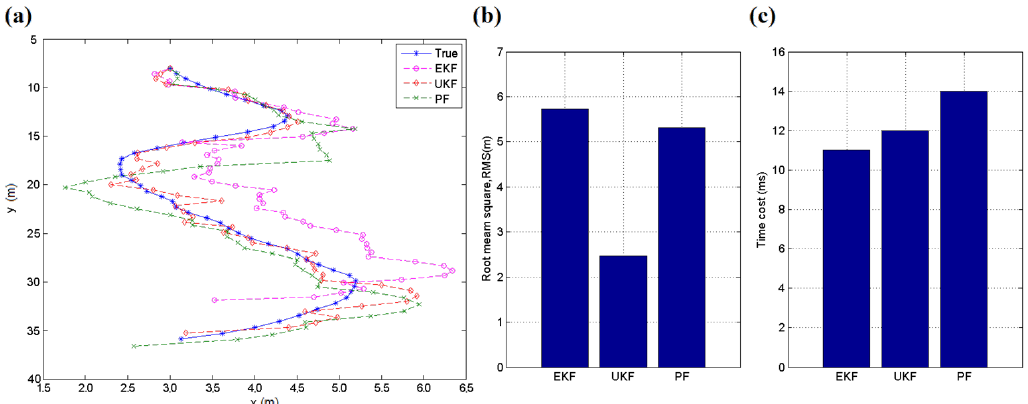
Figure 8. ( a ) Tracking trace of the simulation; ( b ) Root mean square (RMS) errors of the three methods during the simulation; ( c ) Time cost of the three methods during the simulation.